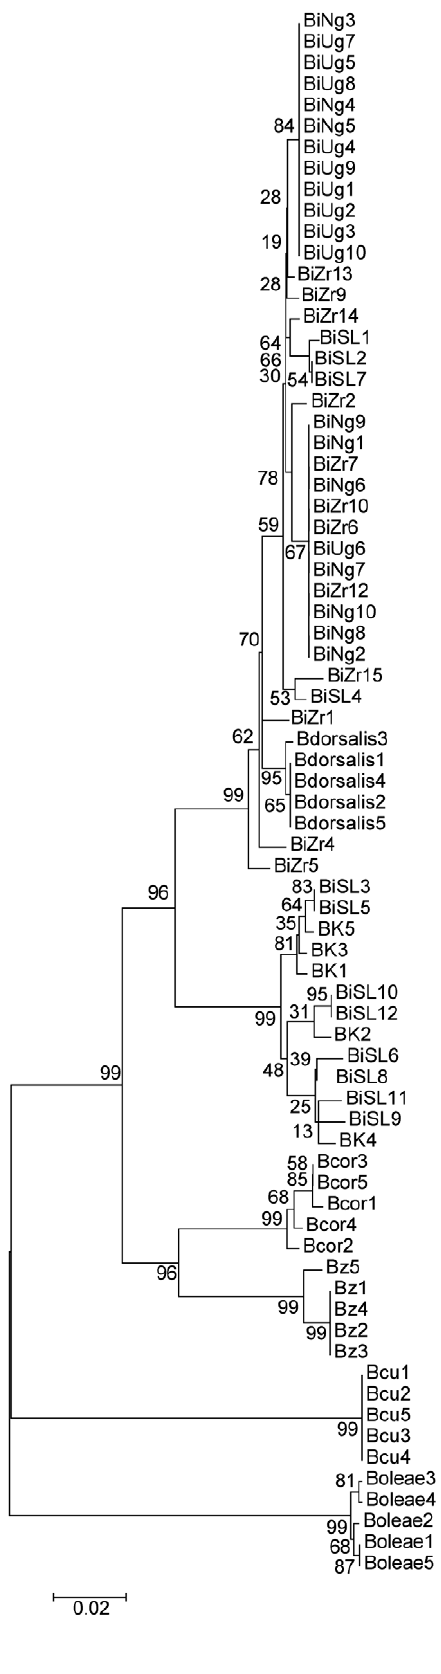
Figure 4. Evolutionary relationships between B. invadens populations and other Bactrocera species included in the study as inferred using Neighbour-Joining method by Mega 5 program (Tamura etal. ,